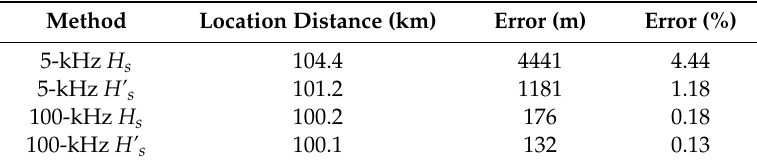
Table 3. Error comparison between H s and H’ s methods.